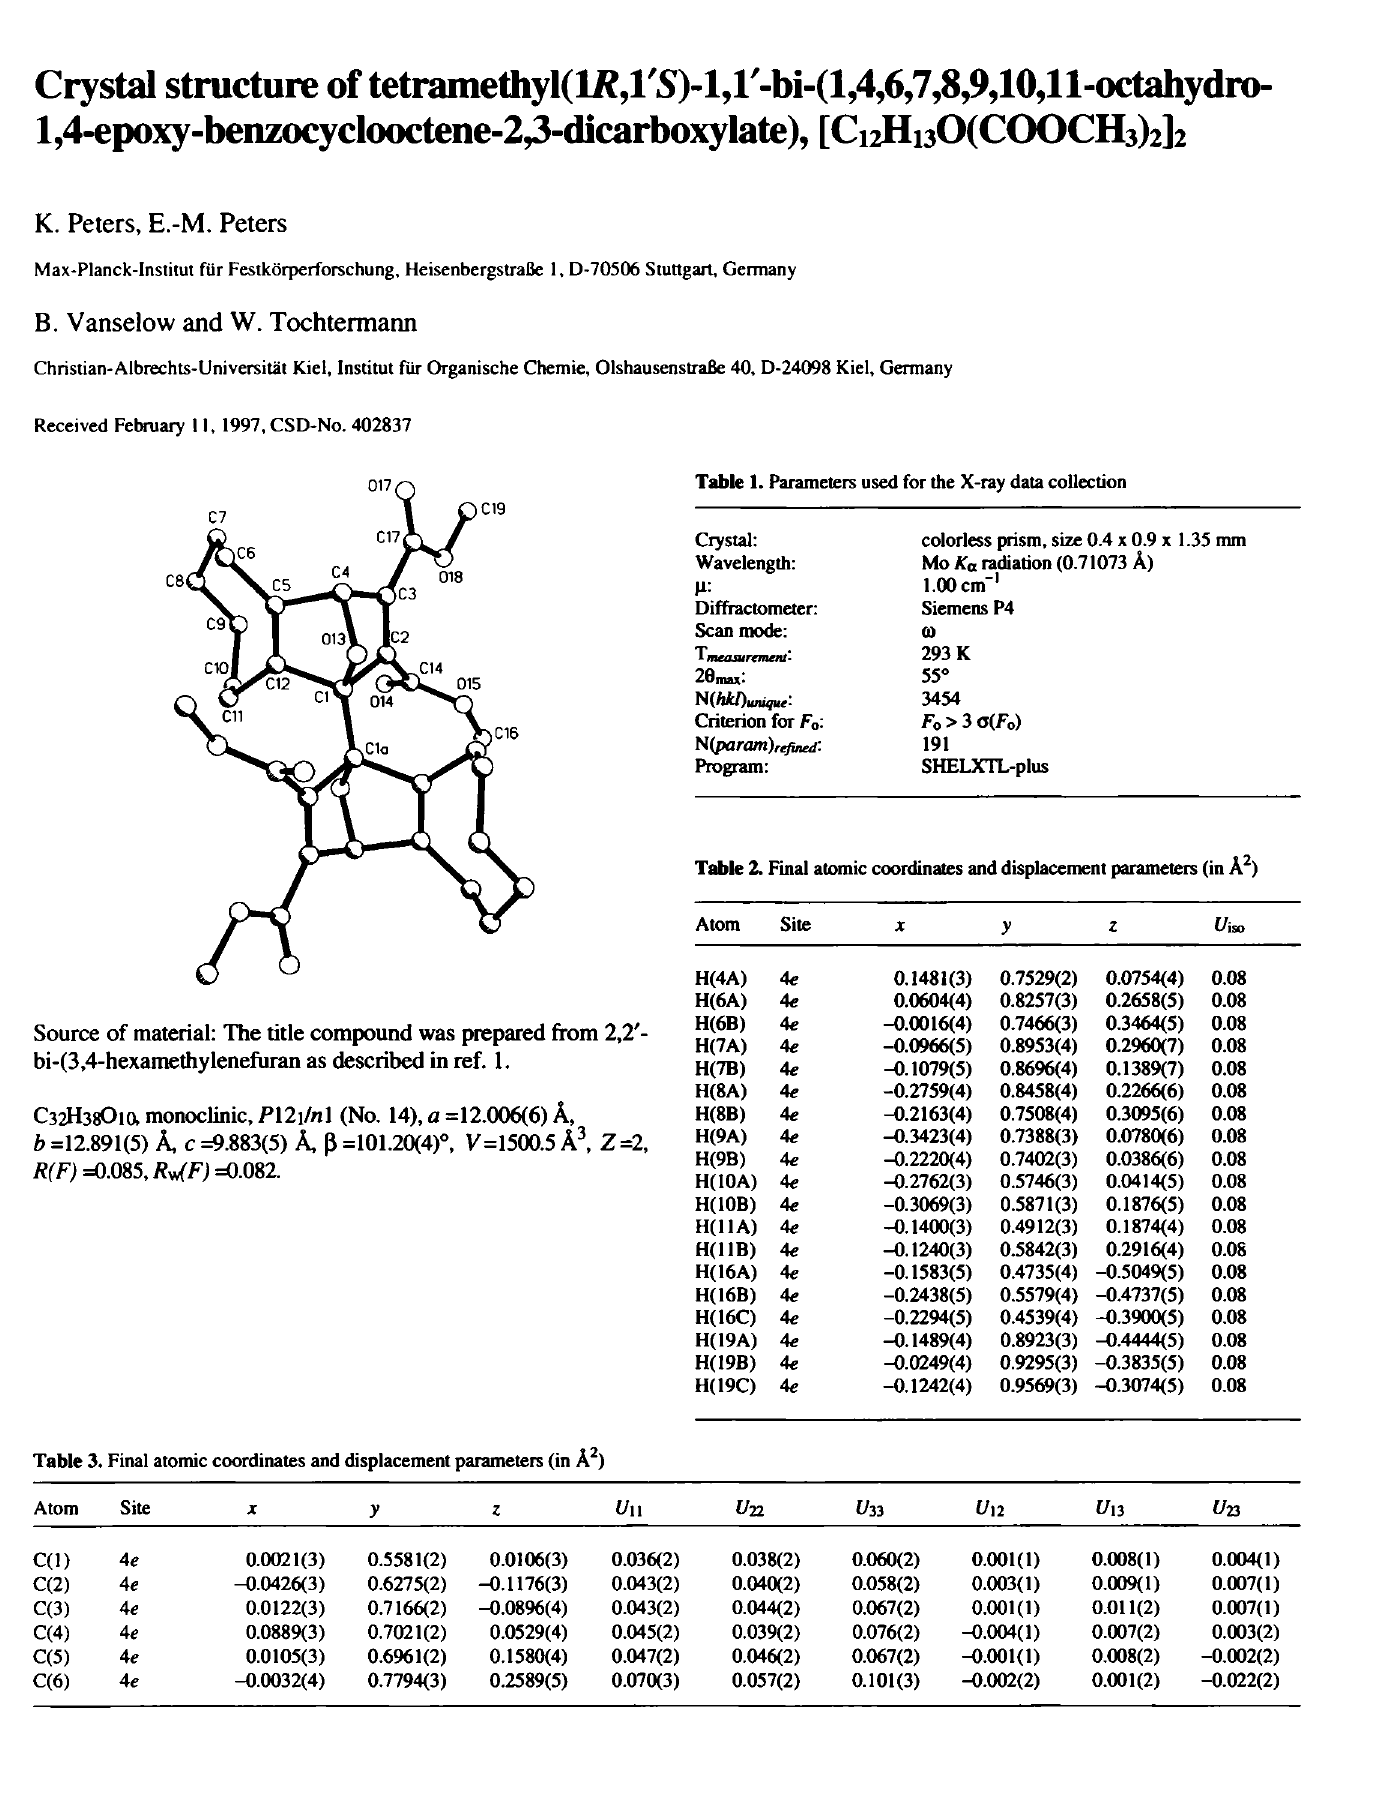
Table 3. Final atomic coordinates and displacement parameters (in